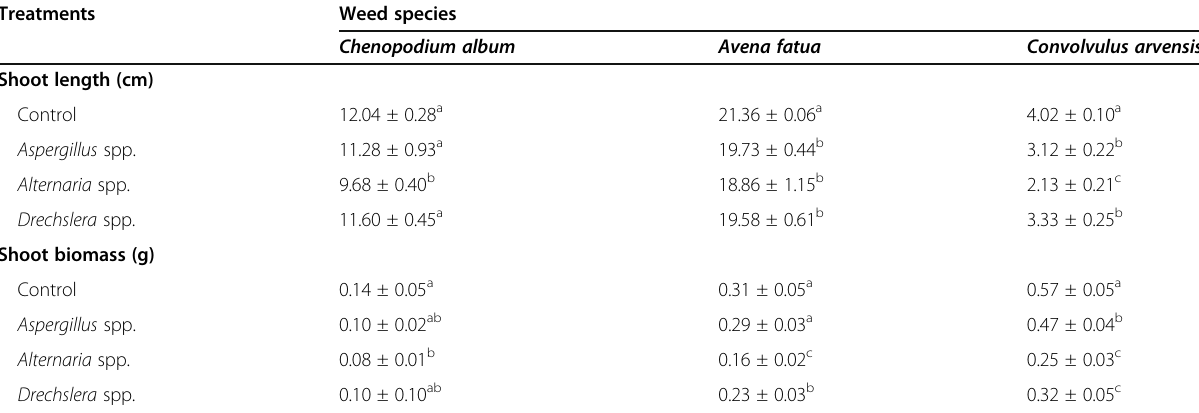
Table 3 Effect of cultural filtrates of endophytic fungi on the growth parameters of weed species in a pot experiment Treatments Weed